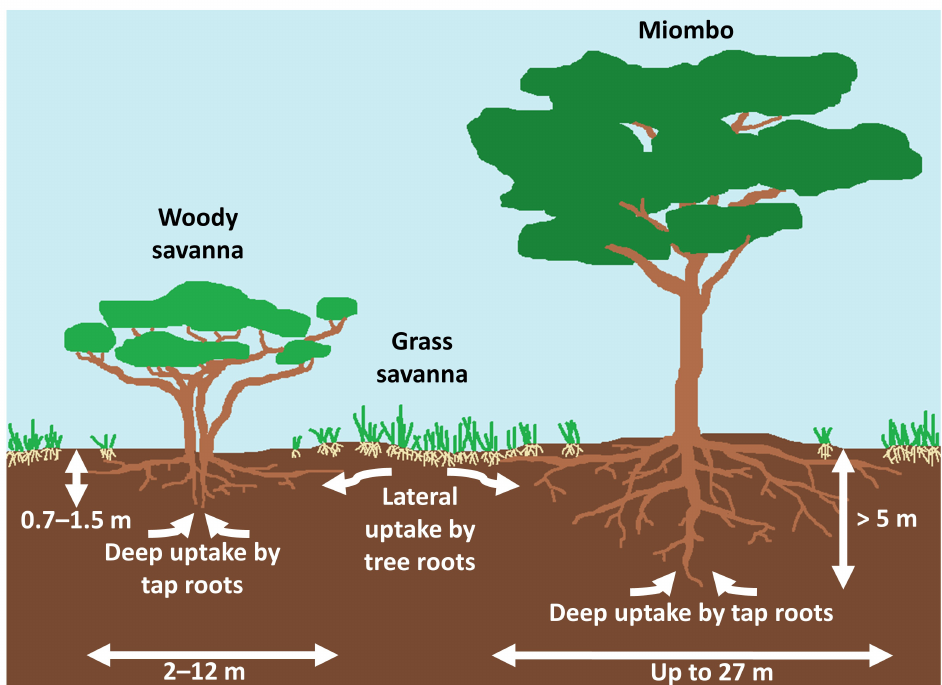
Figure 6. Diagram depicting varying spatial distributions of root zones for woody savanna, grass savanna, and miombo land cover types. The diagram was not drawn to scale, but approximate sizing was determined based on tree heights, vertical root depths, and lateral root lengths found in the literature